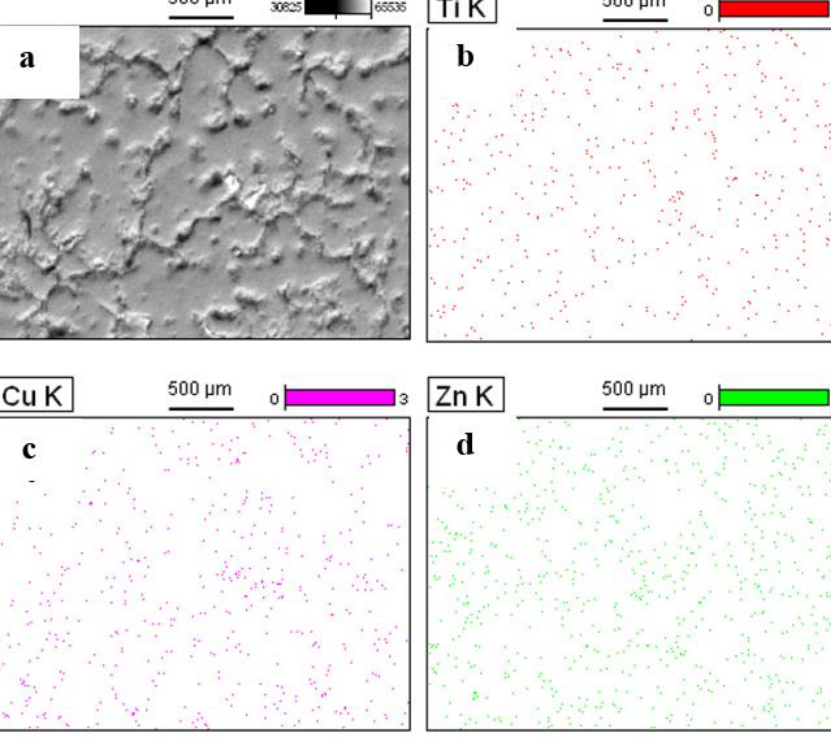
Fig. 5. Al 7075 -6 wt.% TiC alloy (a) SEM image, elemental mapping of (b) Ti, (c) Cu, and (d)